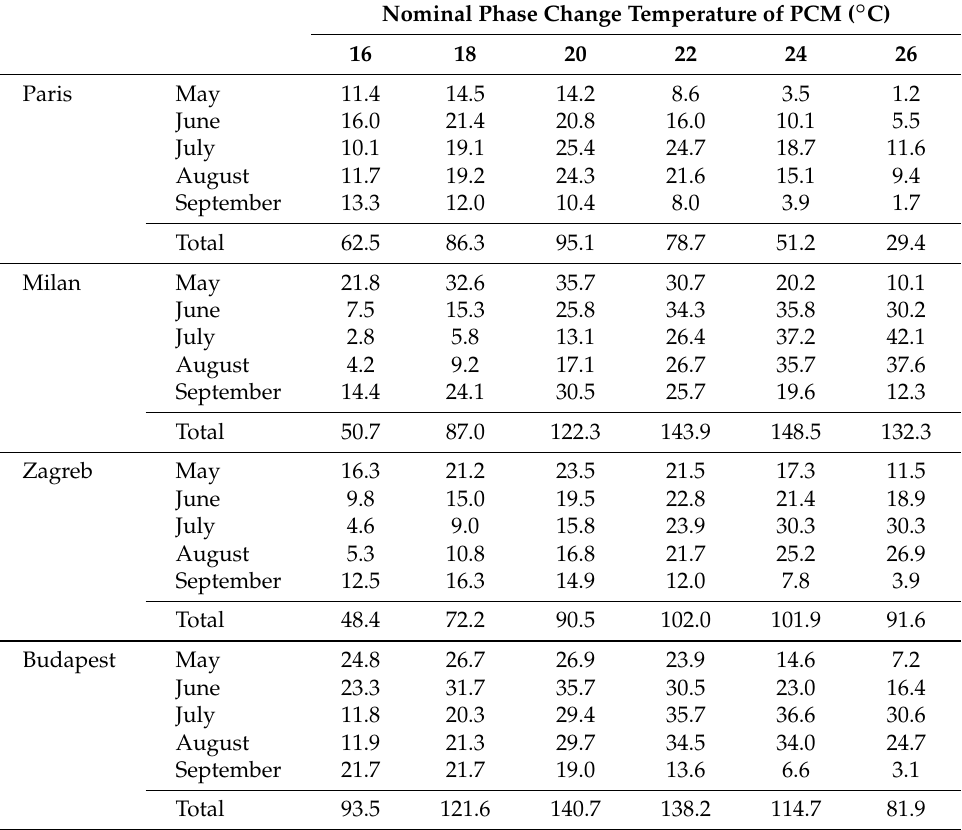
Table 4. Energy saving potential in kWh (cities between 45 ◦ N and 50 ◦